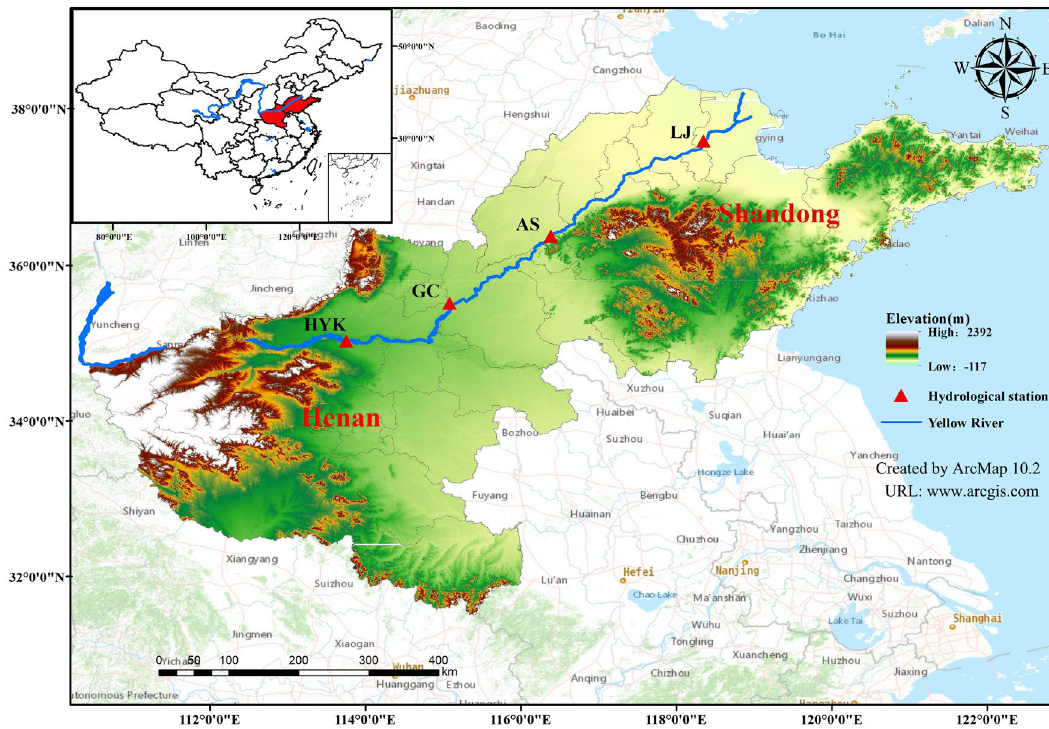
Figure 3. Hydrographic station distribution map.